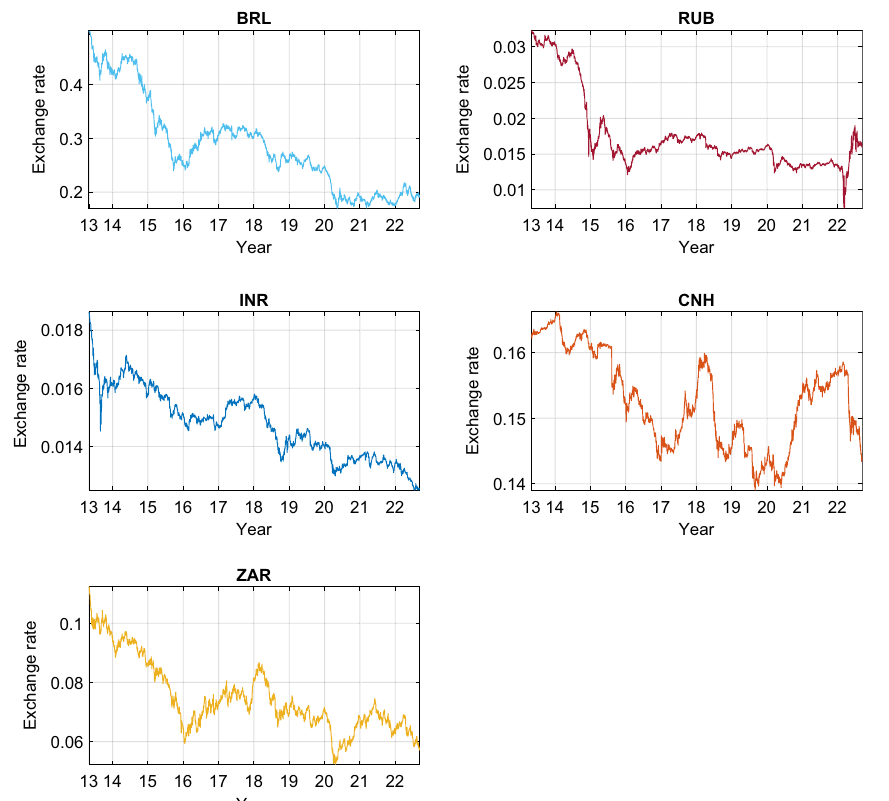
Fig. 3 The BRICS exchange rates quoted against the